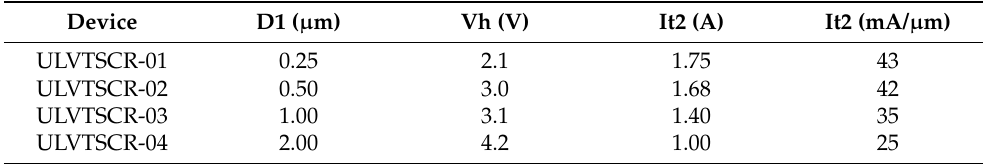
Figure 4. ( a )TLP I-V characteristics and ( b ) leakage of ULVTSCRs with different D1. Table 2. Extracted Vh and It2 of ULVTSCR with D1 variation. Table 2. Extracted Vh and It2 of ULVTSCR with D1 variation.